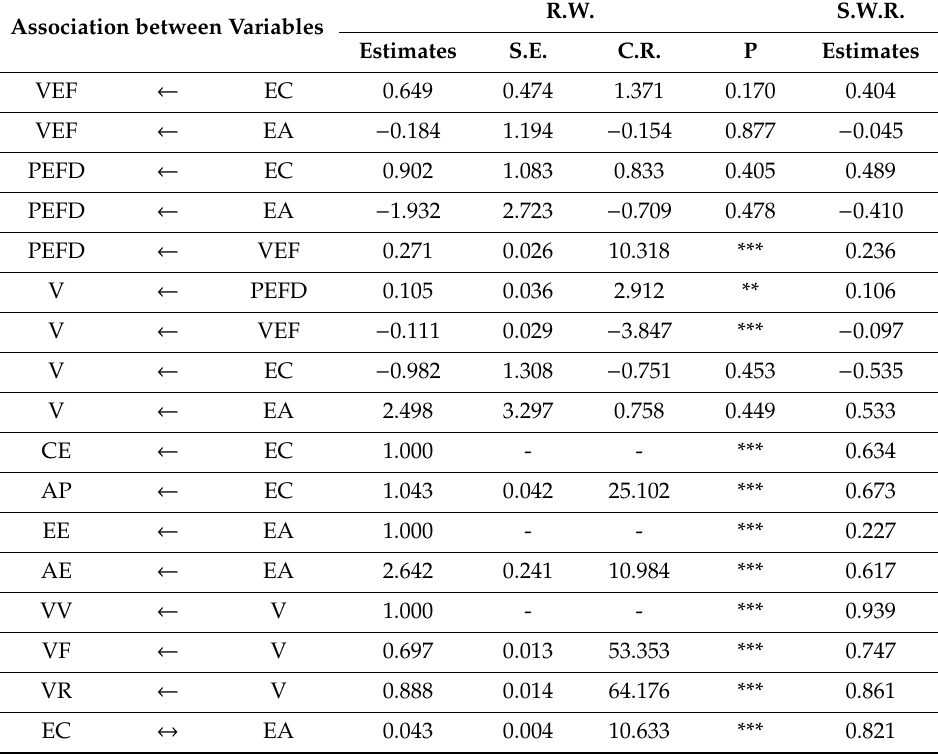
Table 1. Structural model for individuals who regularly engaged in physical activity. Association between